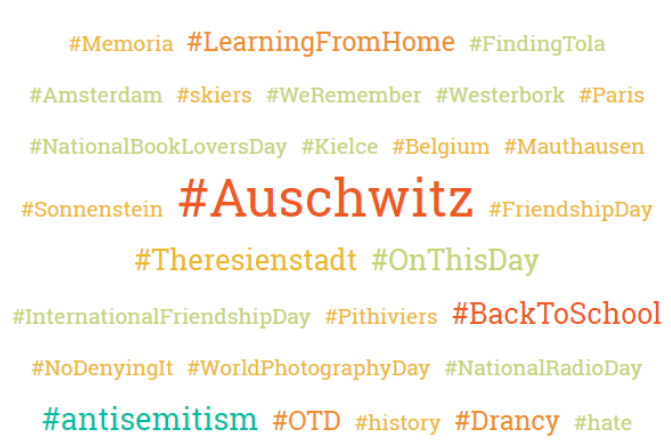
Figure 2. Hashtags that the museums used most frequently on Facebook (relative frequency is expressed both by text size and by colour).